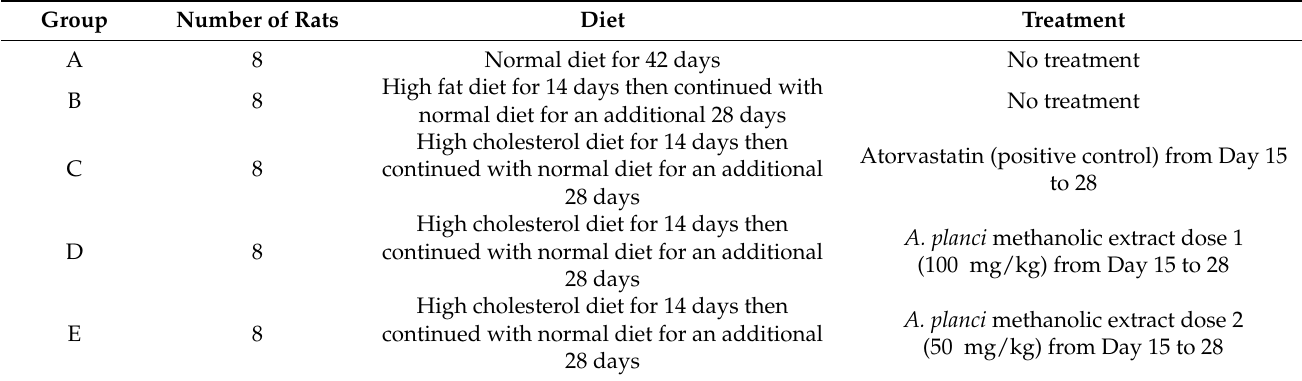
Table 3. Rats grouping for the in vivo study with 28 days treatments ( n =